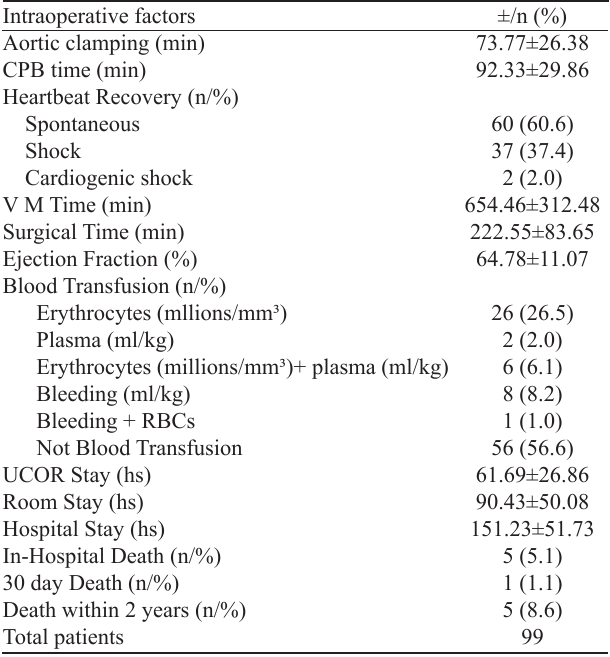
Table 1. Description of intraoperative and postoperative factors of patients undergoing cardiac